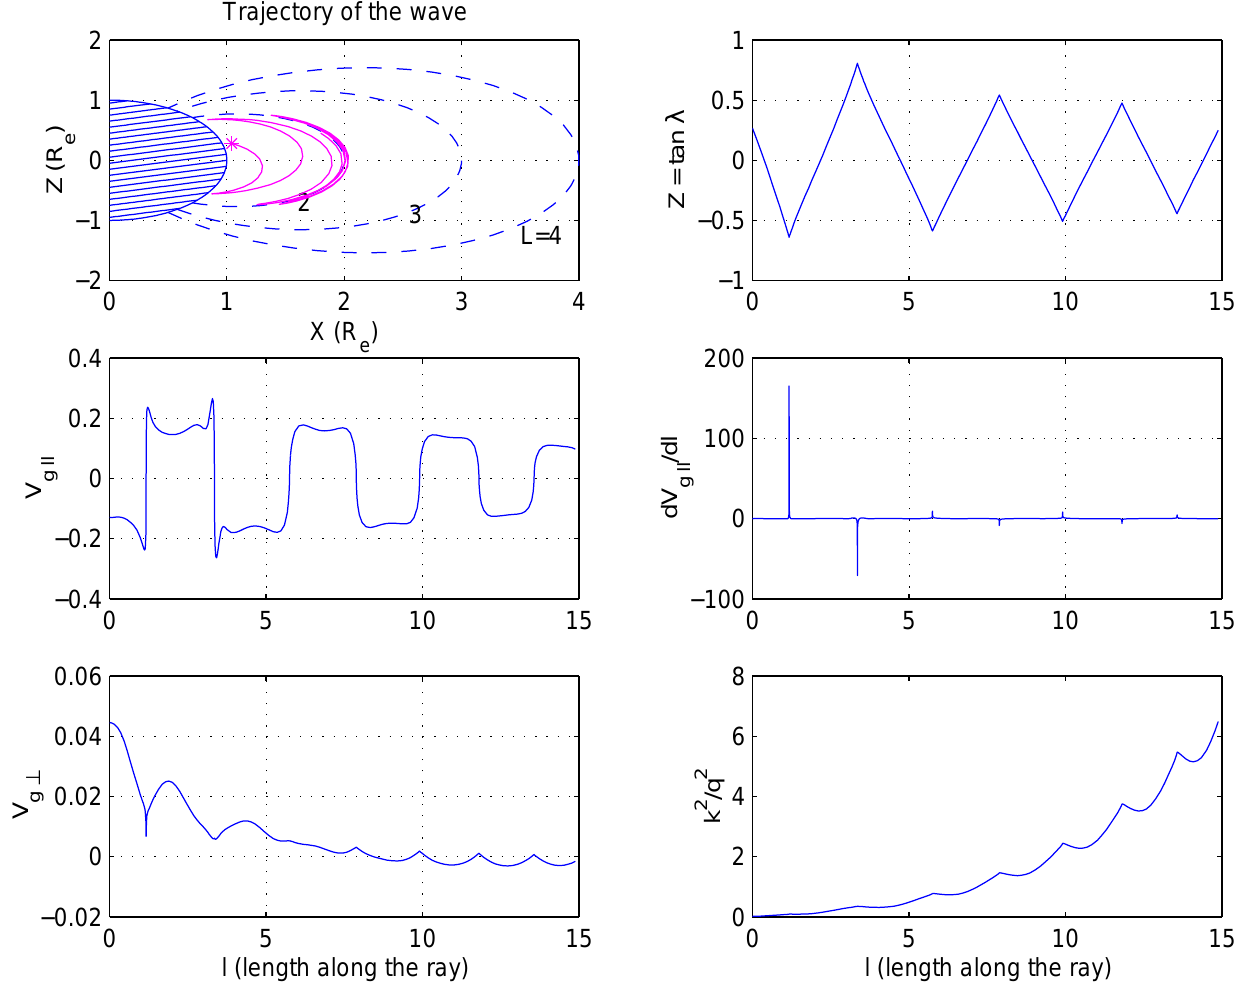
Fig. 3. Ray trajectory and wave propagation characteristics for 5-kHz wave. Comparison of the latitude variation and the reflection parameter shown on the upper and middle right panels, respectively, clearly shows that the reflection takes place when the reflection parameter has a